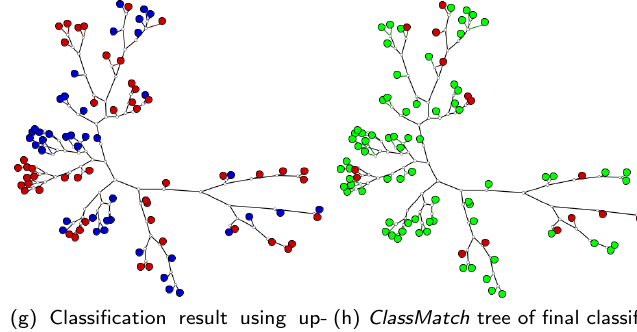
Figure 10. Visualization of the classification process for the Musk1 dataset.